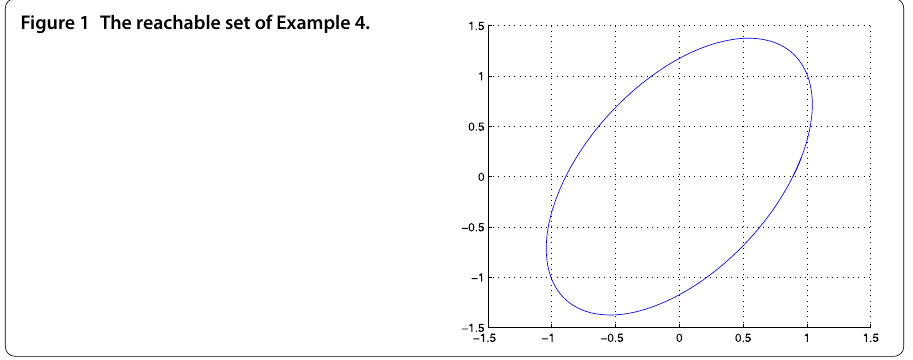
Figure 1 The reachable set of Example 4.